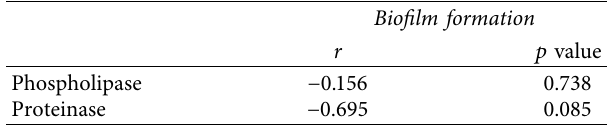
Table 2: Correlation between bioflm formation and phospholi- pase/proteinase